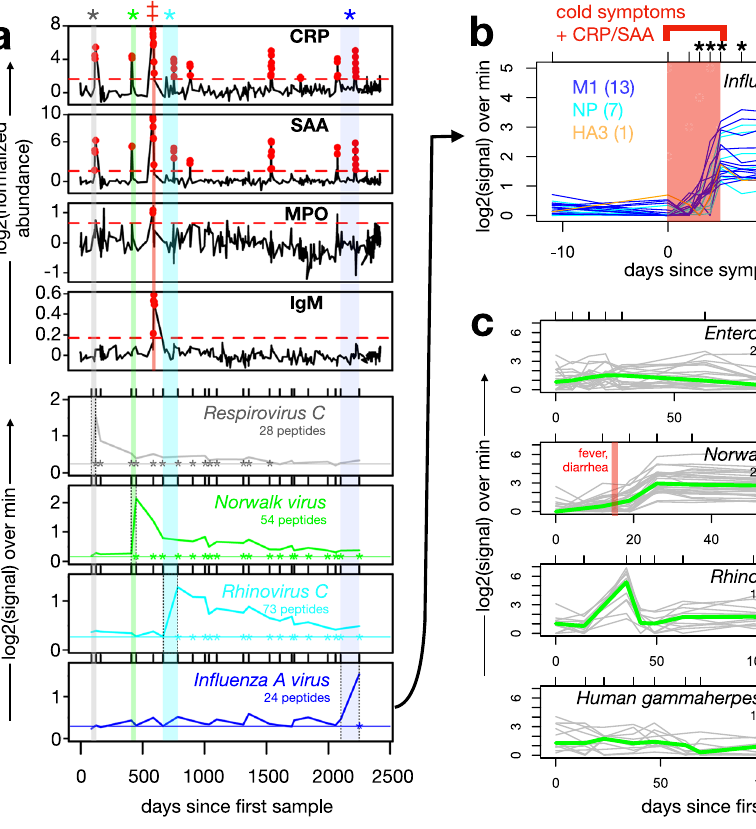
signi fi cantly elevated over this baseline ( p <0.01 by one-tailed paired t test). b For the VAE corresponding to In fl uenza A virus [shown in ( a )], PepSeq assays were conducted on samples from additional timepoints to fi ne-map the association between symptoms, in fl ammatory proteins and virus-speci fi c antibodies. Shown arethePepSeqsignalsforleading-edgepeptides(coloredbytheirproteinoforigin) across the time series, relative to in fl ammatory marker elevations and symptoms (upper red bar). Timepoints with signi fi cantly elevated antibodies are marked (*indicates p <0.05byone-tailedt-test). c Examplesofantibodydynamicsdetected from serial dried blood spot samples in the ‘ MyImmunity ’ cohort. Each plot shows the signalacrosstime for VAEleading-edge peptides (gray lines, medians ingreen) for a species of interest in a different participant. The upper two plots show cases whereaVAEcoincidedwithafebrileepisode(verticalredbars).Thelowertwoplots show VAEs characterized by rapidly-declining reactivity that returned to baseline within ≤ 10 days. Tick marks at the top of each plot indicate sampled timepoints. Source data are provided as a Source Data fi